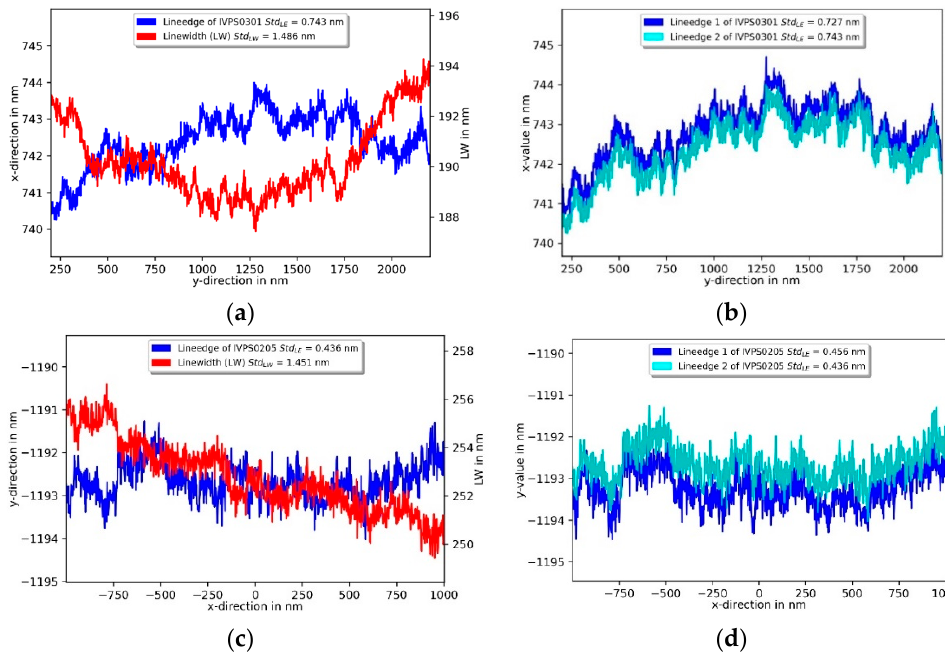
Figure 16. Line edge roughness (LER) and line width (LW) roughness measurement of two orthogonally mounted IVPS100-PTB structures (IVPS0301 and IVPS0205, M35_S5) at a 100 nm depth with the 3D-Nanoprobe in ( a ) and ( c ). In ( b ) and ( d ) the lineedge of two repeated measurements are shown.